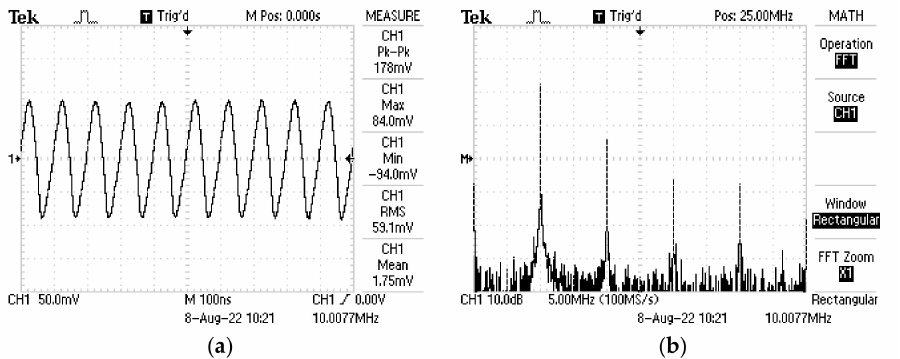
Figure 9. The output waveform of the QO1 at f Q = 10.0000 MHz with C 1 = C 2 = 33 pF and C 12 = 16.5 pF: ( a ) the output voltage (the horizontal scale is 100 ns/div and the vertical scale is 50 mV/div (the attenuation option is 10 X )); ( b ) the output spectrum with sweep along the x -axis from 0 Hz to 50 MHz (at 5 MHz